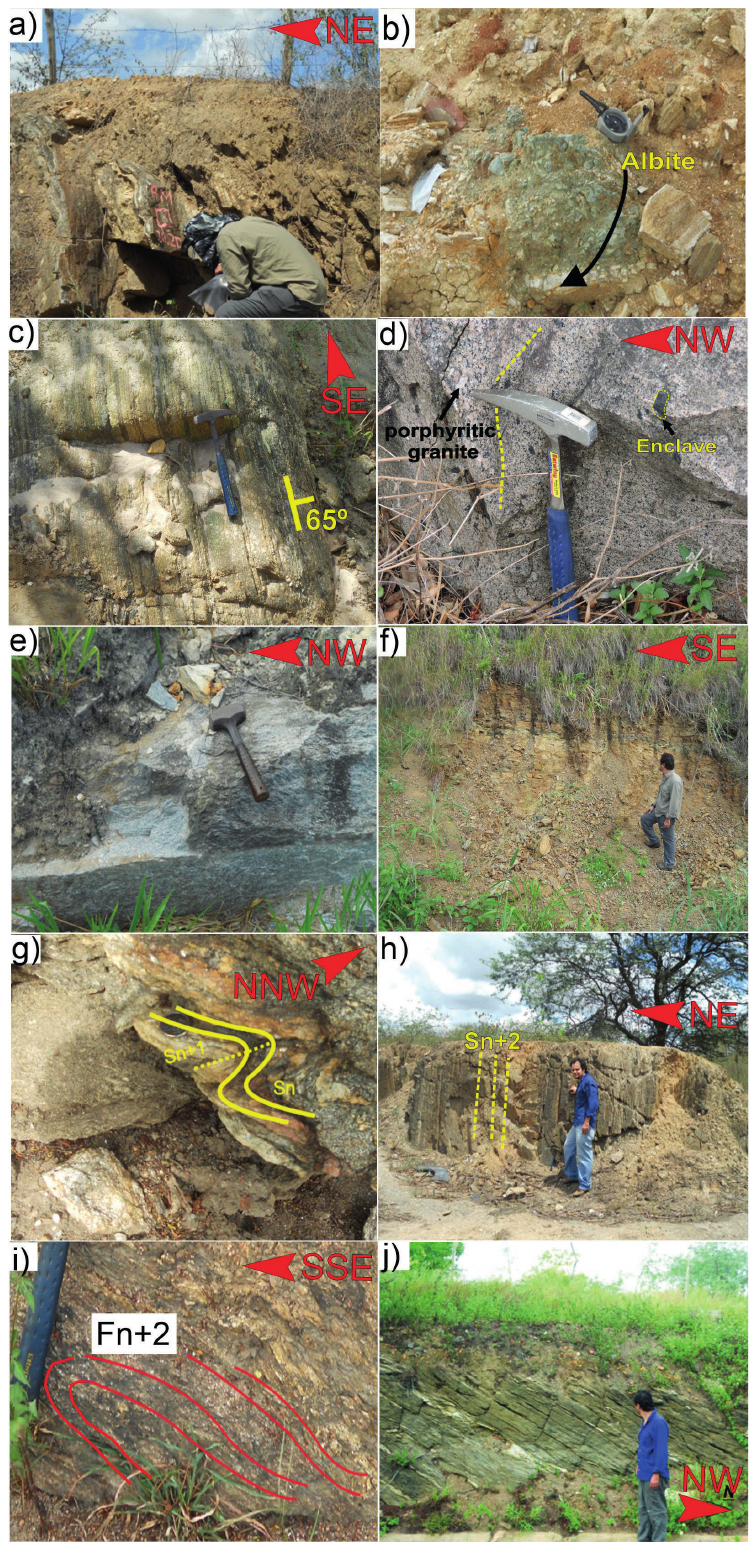
FIGURE 4 . General field and structural aspects of the studied region. a) orthogneiss showing gneissic banding with folded structure in the Floresta Complex. b) Mafic metavolcanic rock from the Surubim-Caroalina Complex showing albitization process. c) Metaritmite with high-angle foliation related to Dn+2 event. d) Sub-rounded microenclave-rich monzodioritic rock in contact to porphyritic granite. e) Hornblende diorite with biotite oriented by magmatic foliation. f) Phyllite of the basal unit of Vaza Barris Domain showing subhorizontal primary layered structure. g) gneiss showing asymmetric fold of generation Fn+1 and controlled by contractional tectonic Dn+1 on an axial-plane foliation Sn. h) Sn+2 high-angle foliation related to dextral transcurrent shearing of Pernambuco Lineament. i) Tight fold corresponding to the Fn+2 tectonic phase with vergence to SSE. j) Contractional tectonic regime (Dn+1) showing vergence to